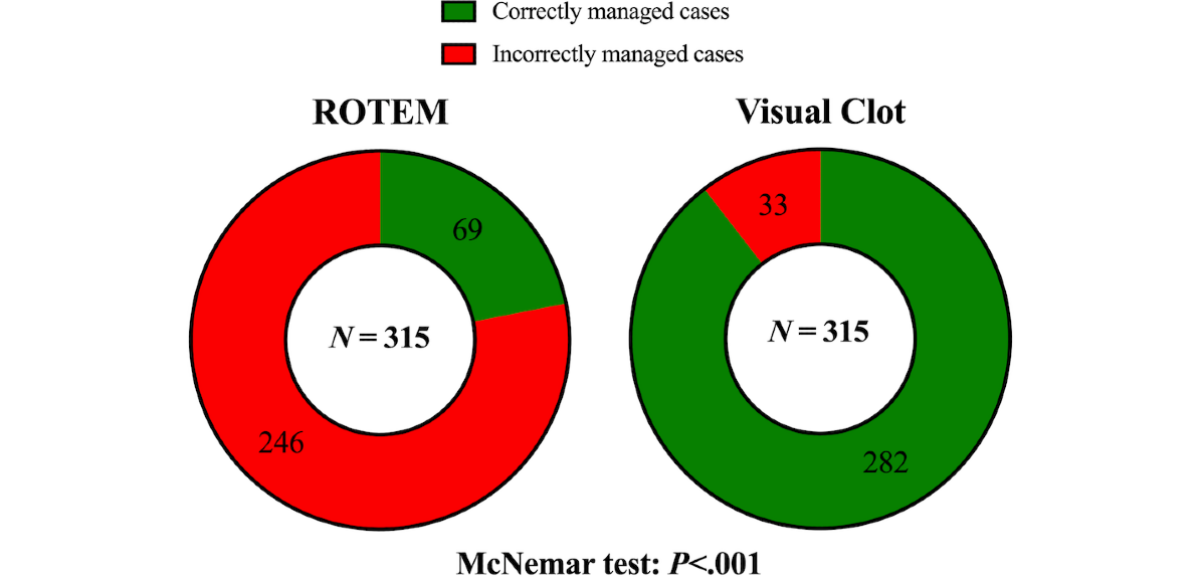
Figure 3. Donut charts displaying the binary performance defined as the number of correctly and incorrectly solved cases using standard ROTEM results (left donut) or Visual Clot (right donut). The unadjusted analysis using the McNemar test showed very strong evidence for a difference between the 2 viscoelastic modalities ( P <.001). N=315 per viscoelastic modality. ROTEM: rotational